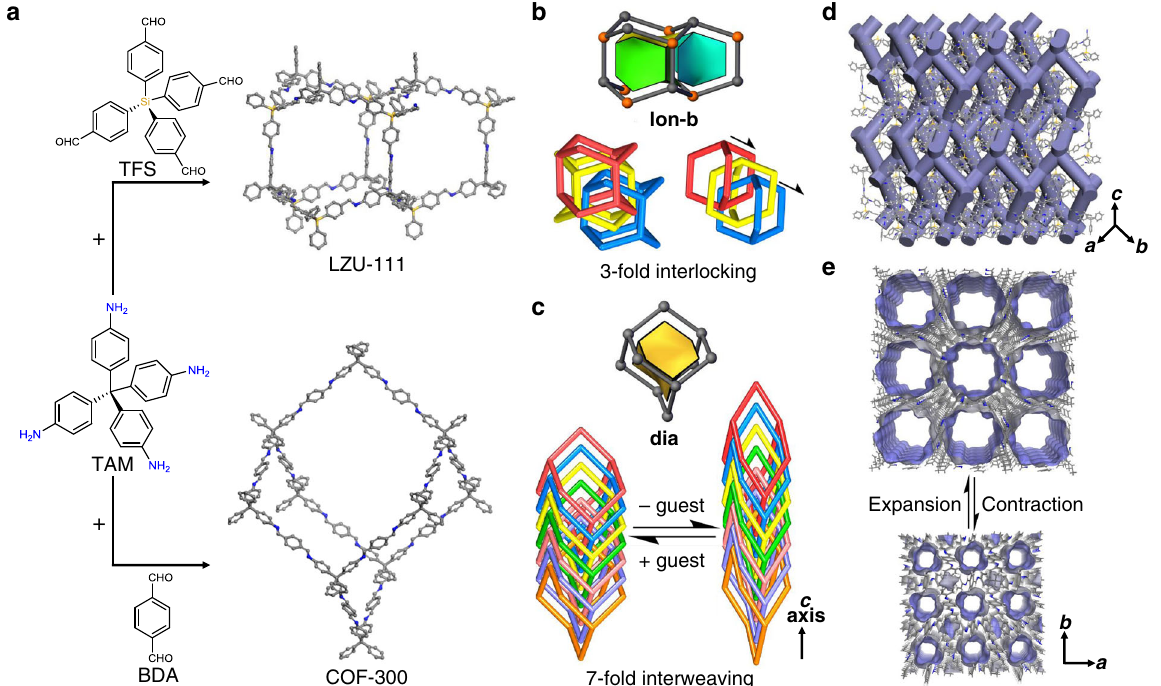
Fig. 1 Synthetic routes, crystal structures, interpenetration, and porosity diagrams of LZU-111 and COF-300. a Synthesis and SXRD structures of LZU- 111 and COF-300 (C, grey; N, blue; Si, orange. H is omitted for clarity). LZU-111 is connected by tetrakis(4-aminophenyl)methane (TAM) with tetrakis(4- formylphenyl)silane (TFS) while COF-300 is linked by TAM with terephthaldehyde (BDA) 27 . b The lon-b net adopted by LZU-111 and their interlocked fashion of 3-fold interpenetration. c The dia net adopted by COF-300 with 7-fold interweaving for structural fl exibility upon guest inclusion and removal. d The structure with 3D spiral channels of LZU-111. e The 1D channel in COF-300 capable for contraction and